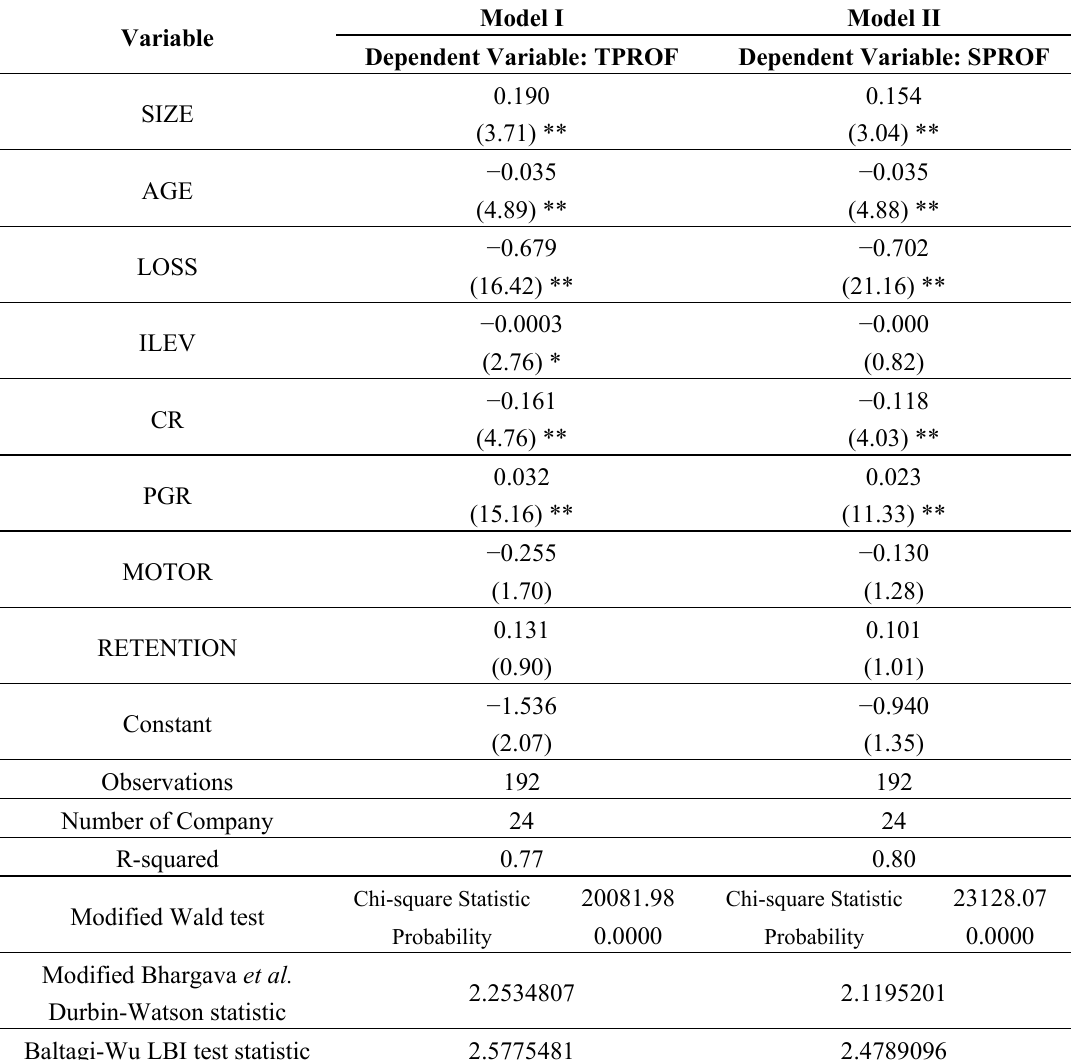
Table 6. The Results of Fixed Effects